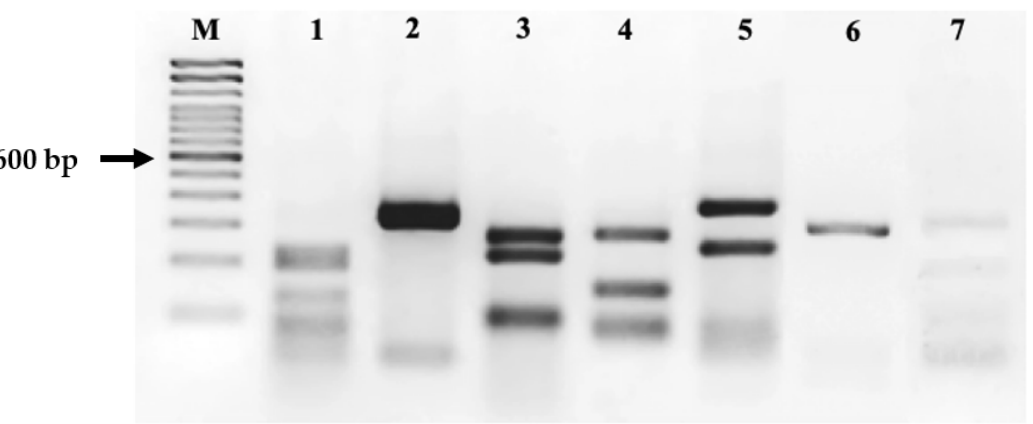
Figure 2. COIBar-RFLP profile of seven seafood species using Msp I. Lane M: 100 bp Marker. ( 1 ) A. minuta ; ( 2 ) E. encrasicolus ; ( 3 ) N. tangkahkeii ; ( 4 ) L. niloticus ; ( 5 ) P. fluviatilis ; ( 6 ) S. pilchardus ; ( 7 ) P. hypophthalmus.